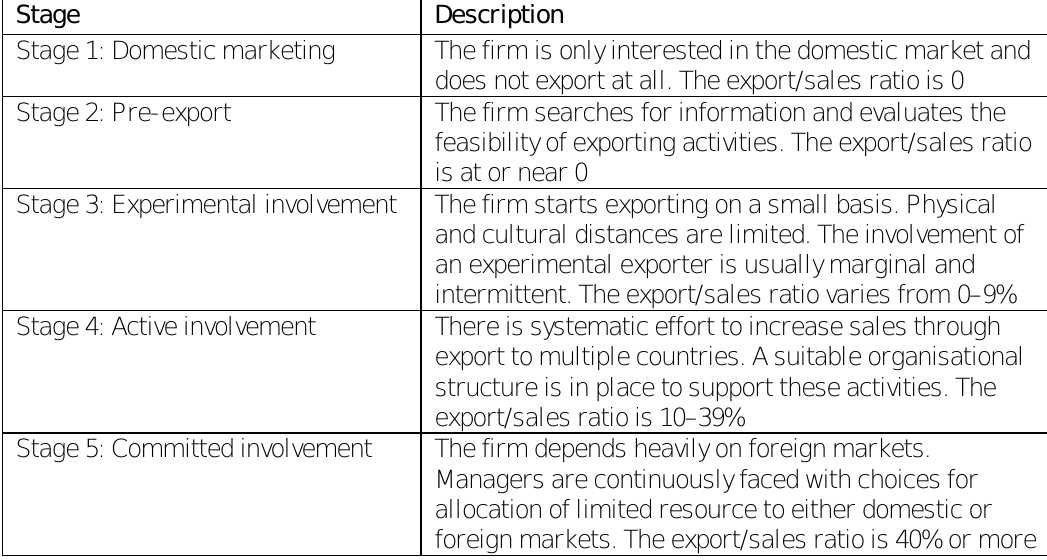
Table 3: Stages in exporting